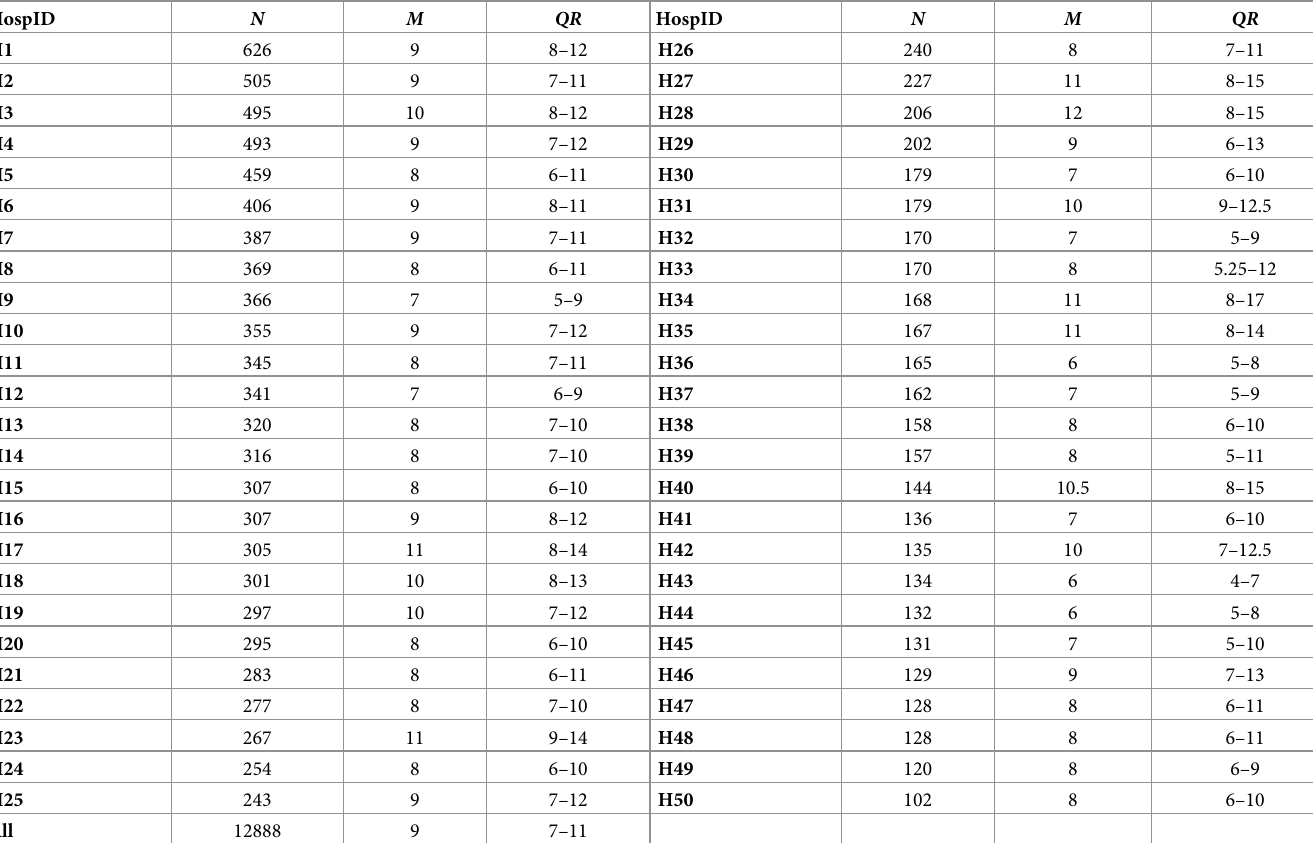
Table 1. Summary of patients’ LOS variations by